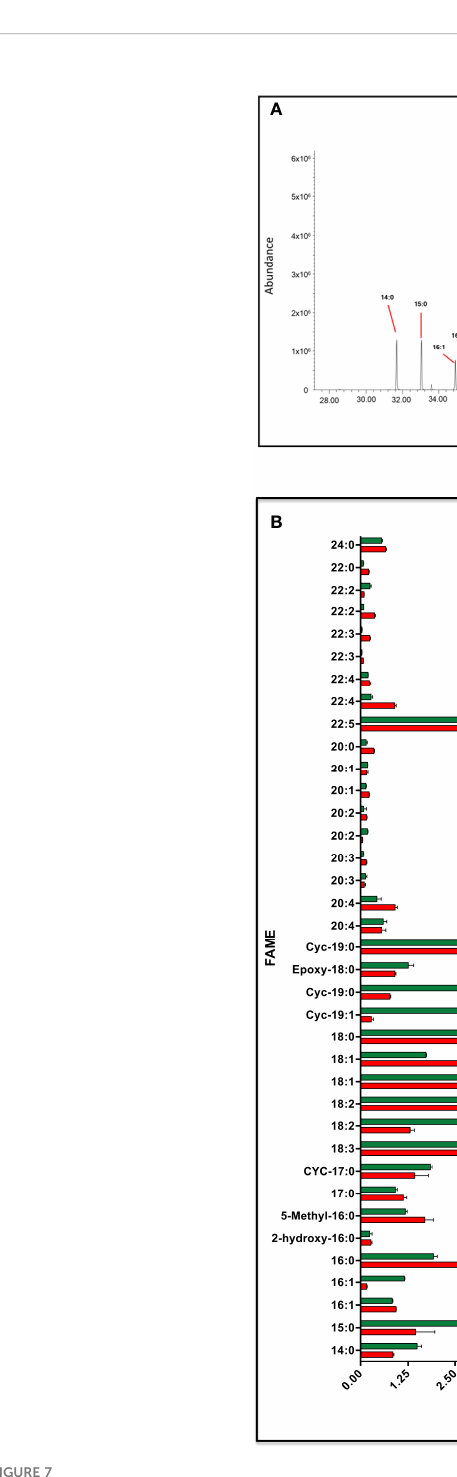
FIGURE 7 Fatty acid pro fi le in C. fasiculata . (A) GC-MS chromatogram analysis of WT C. fasiculata cultured in standard fat (serum)-free media. Peaks, eluted at different retention times (X axis) and with different abundance (Y axis), are assigned to correspondent FAs. The 20C (green bracket and insert) and 22C PUFAs (light blue bracket and insert) are expanded. (B) The bar chart shows the FAME (or FAs) (Y axis, the order follows increasing retention time) and the relative abundance (X axis) found in C. fasiculata WT grown in standard fat (serum)-free media at 27°C and at 20°C, as shown in the legend. Values are the mean of three independent biological replicates (n=3). Error bars represent the standard deviation of each mean (±). All FAs were identi fi ed using GC-MS based upon retention time, fragmentation, and comparison with standards. Statistical analysis was performed by PRISM 6 by using One-way ANOVA multiple comparisons based on a Tukey t-test with a 95% con fi dence